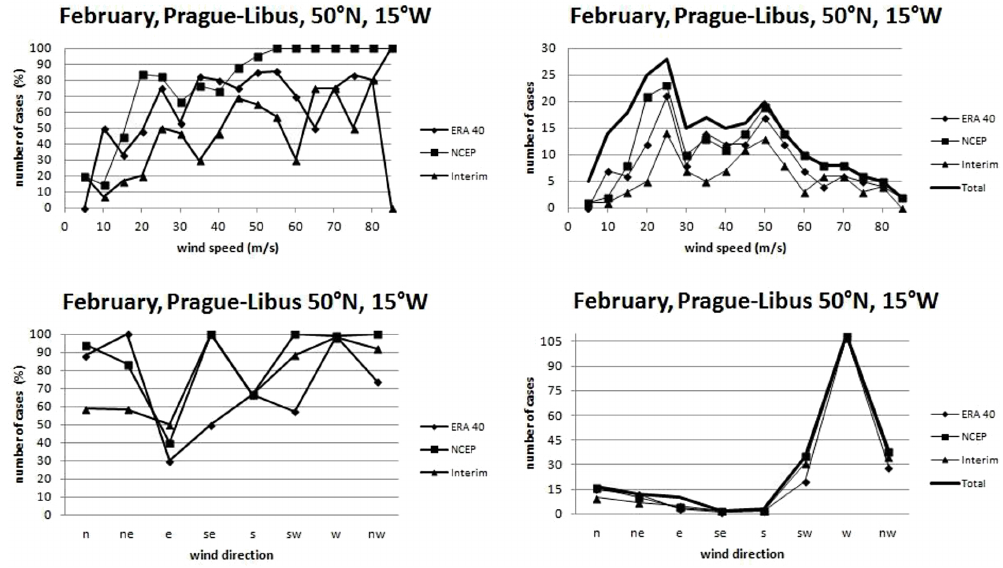
Fig. 8. Number of cases in which the difference between the reanalysis and the Prague-Libus station for wind speed is smaller than 15% (top panel), or for wind direction is smaller than 45 ◦ (bottom panel) at 10hPa. Left panels are in %, right panels show the number of cases.